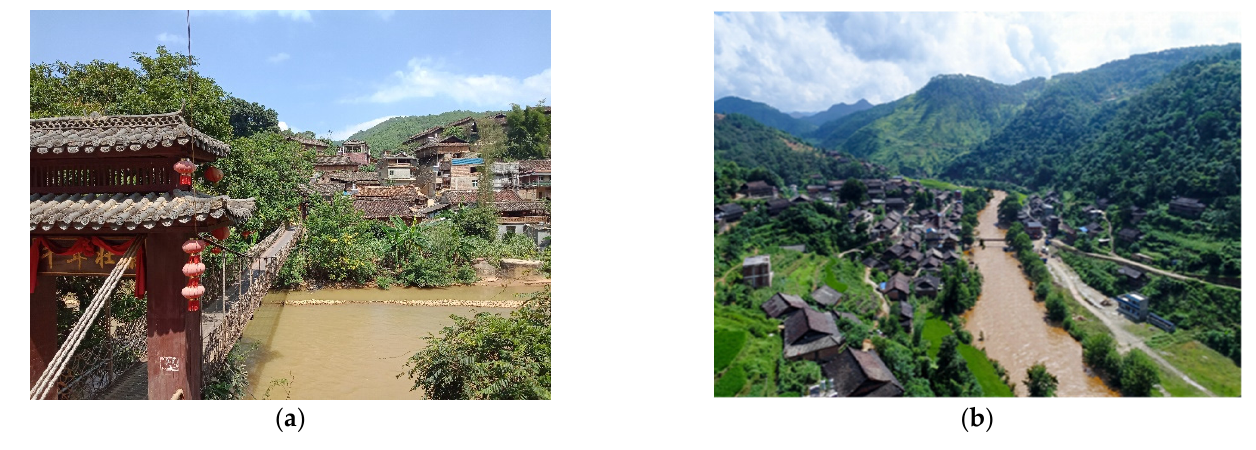
Figure 6. Examples of cultural–ecological tourism. ( a ) Cultural landscape; ( b ) Landscape scenery). Models in Moderately to Severely Vulnerable Zone